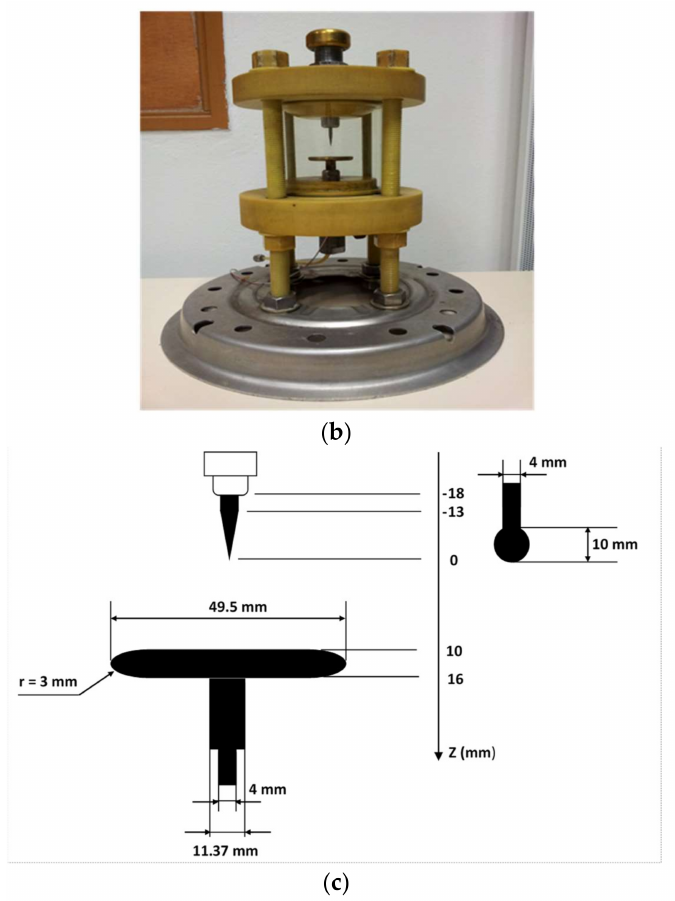
Figure 1. Experimental setup: ( a ) diagram of electrical circuit; ( b ) general view of the test cell containing point-plane electrodes geometry; and ( c ) details on the dimensions of